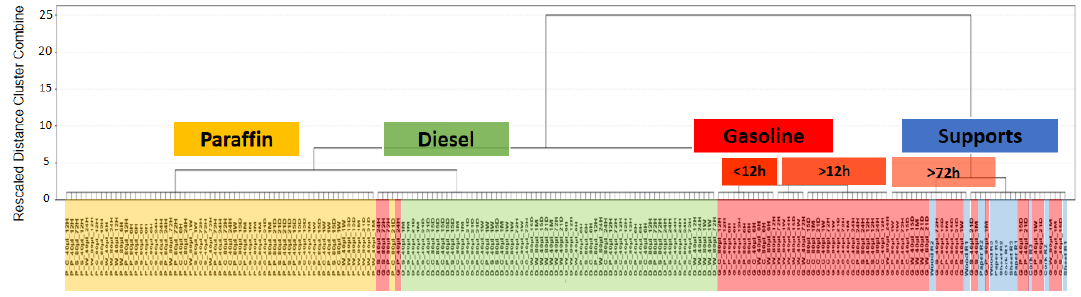
Figure 2. Dendrogram obtained in the HCA using average TIMS for all the weathered samples ( n = 200) with and without PDPs.